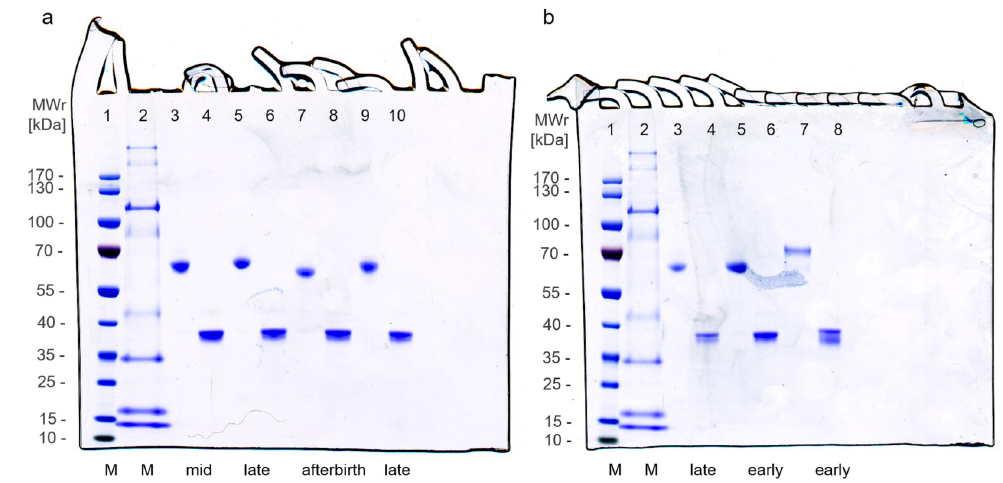
Fig 1. Gel images of seven different purified bovine pregnancy-associated glycoproteins (boPAG) samples from four different pregnancy stages. The protein samples (1 μ g/lane) were either enzymatically deglycosylated with Peptide- N-Glycosidase F (PNGase F) (lane 4, 6, 8, 10) or left untreated (lane 3, 5, 7, 9). Molecular weights of the marker (M)-bands (lane 1, 2) are indicated on the left (kDa). Early pregnancy samples of lane 7 (b) and lane 8 (b) were not analyzed by mass